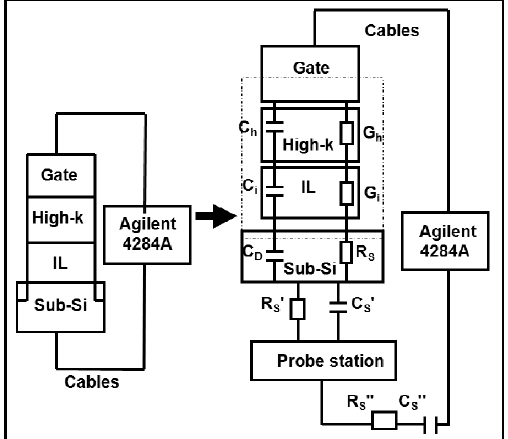
S ) and the lossy interfacial layer effect D and conductance G ). The dashed box includes surface i i , high- k conductance h and conductance G . The oxide capacitance i i and the lossy interfacial layer capacitance C h i